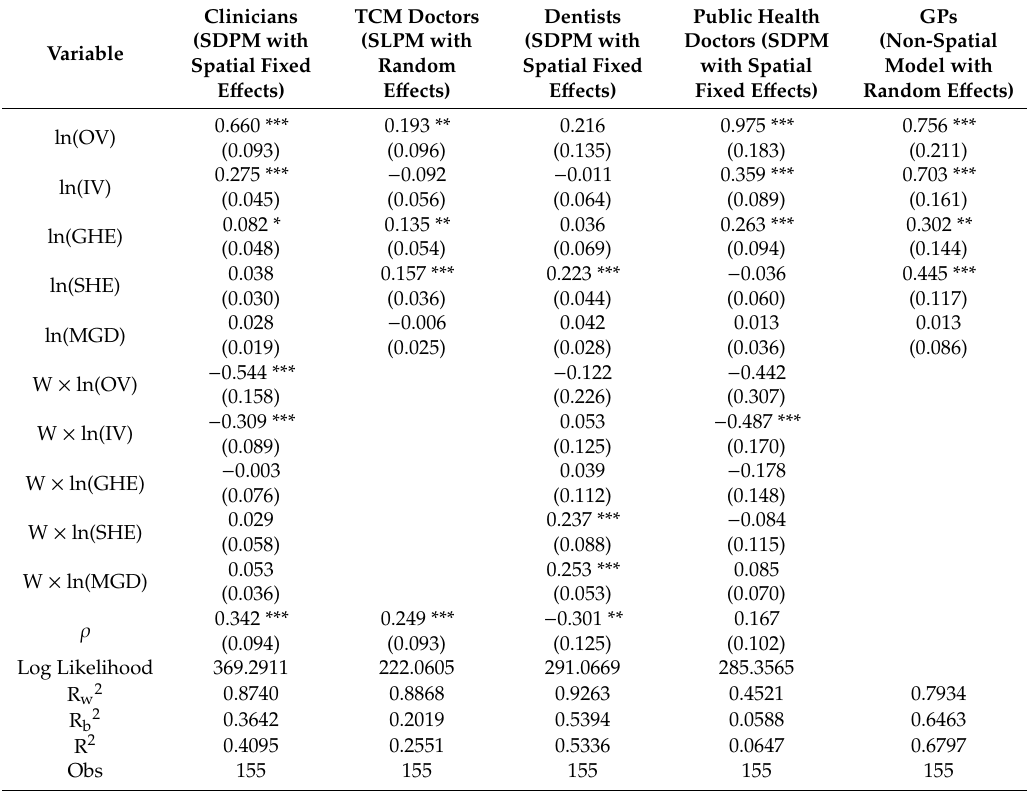
Table 4. Best estimations models for estimating di ff erent subtypes of licensed